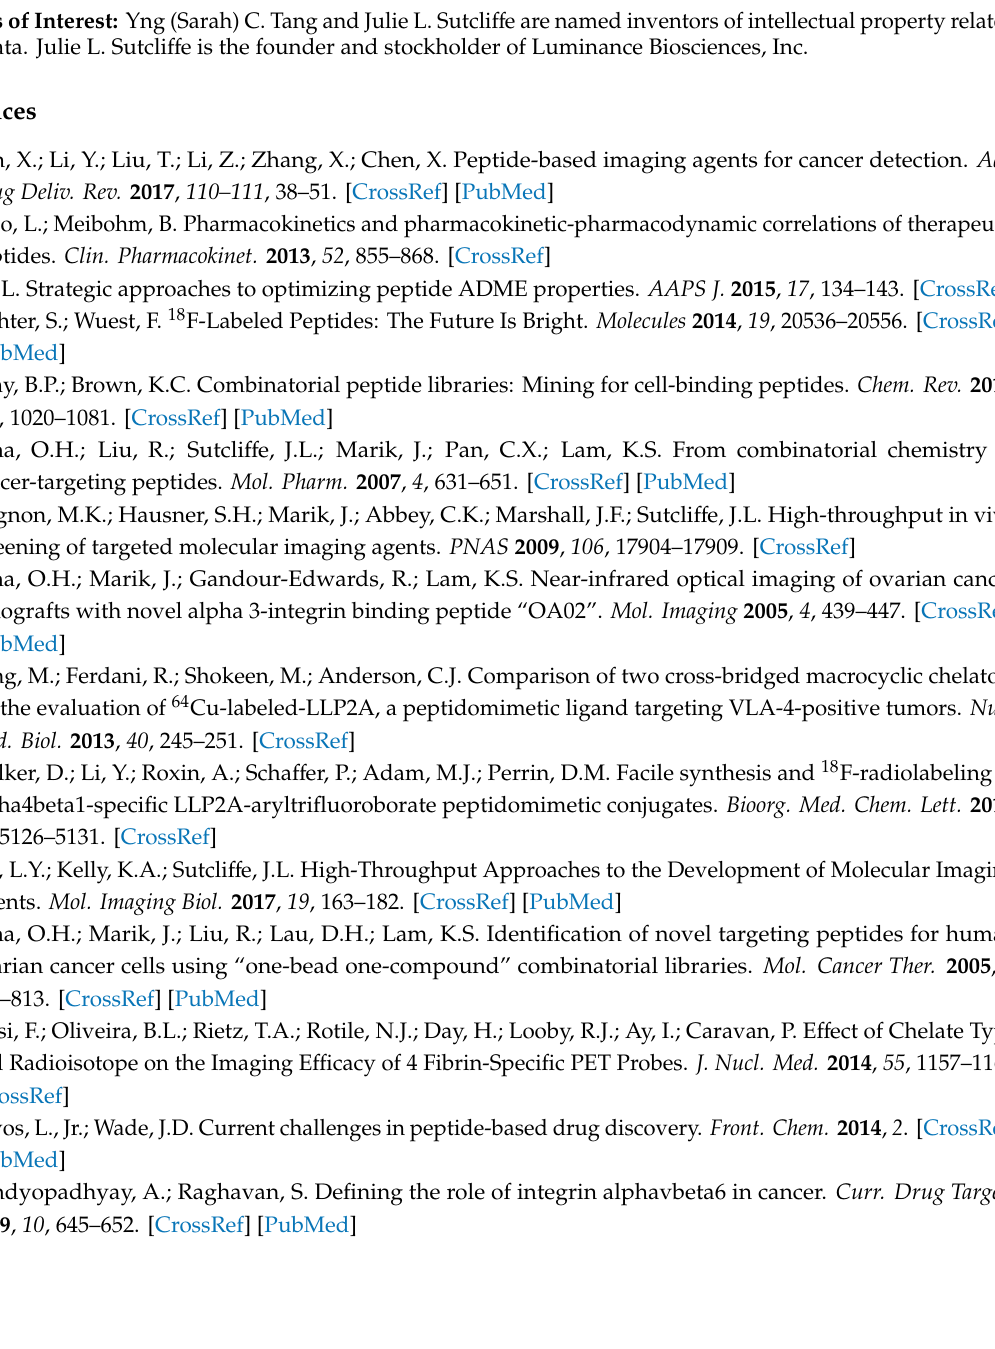
Supplementary Materials: The following are available online. Table S1: Analytical data of synthetic peptides showing retention time, purity, and mass confirmation; Table S2: Analytical Radio-RP-HPLC chromatogram confirming the purity of [ 18 F]peptides; Figure S1: Analytical RP-HPLC chromatograms confirming the purity of synthetic peptides; Figure S2: Mass analysis of synthetic peptides using MALDI / MS; Figure S3: Radio-RP-HPLC of [ 18 F]peptides showing the radioactive PMT trace (red) and their co-injected [ 19 F]peptide standards (green